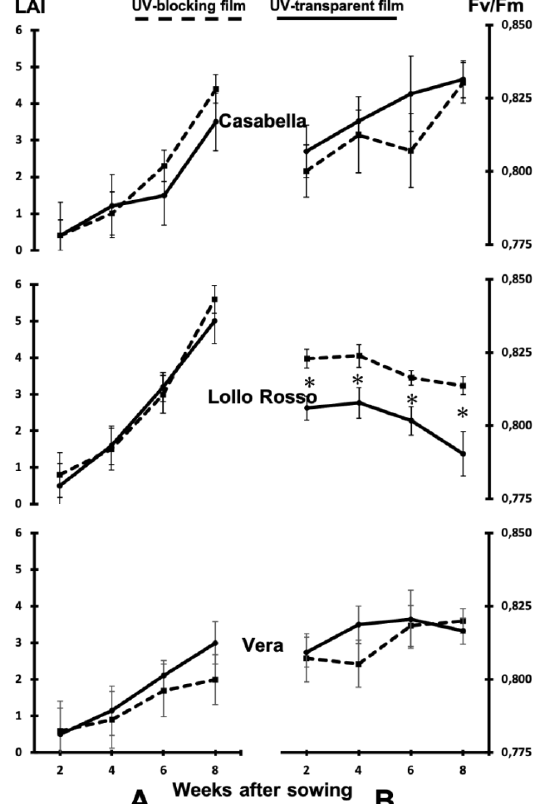
Figure 5. Effects of plastic sheeting on the leaf area index (LAI) ( A ) and photosynthetic efficiency ( B ) in three cultivars of lettuce. Vertical bars show SE ( n = 18). * indicates significant differences within each cultivar between UV-transparent and UV-blocking film according to the LSD test at p < 0.05. No symbol indicates no differences.